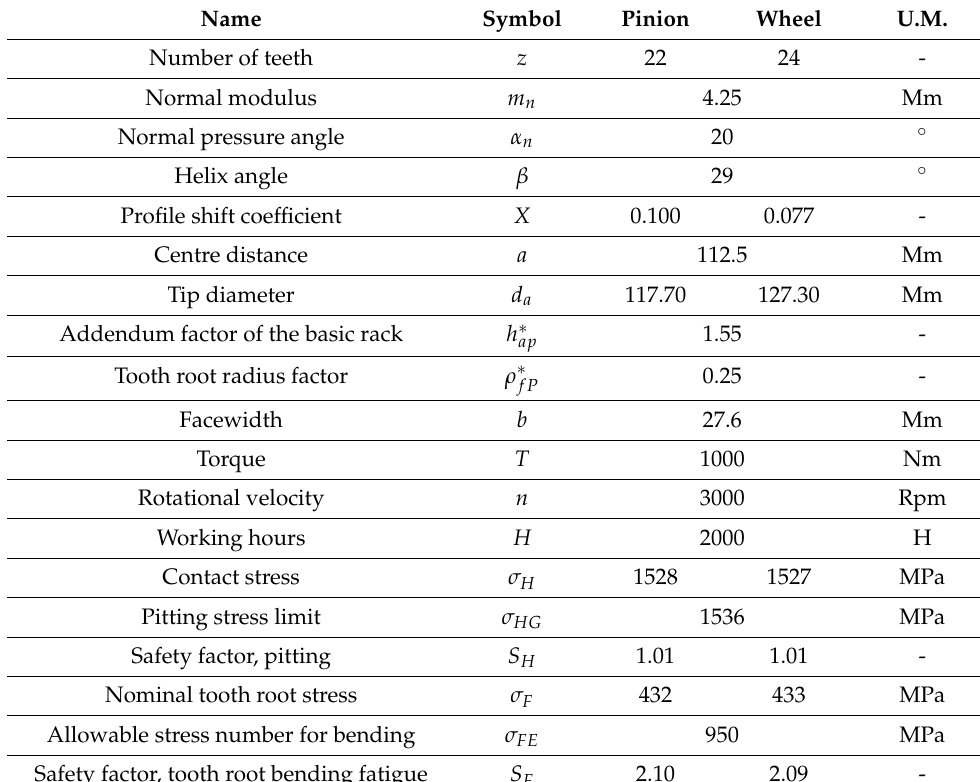
Table 1. Main geometrical data and calculated safety factors acc. to ISO 6336